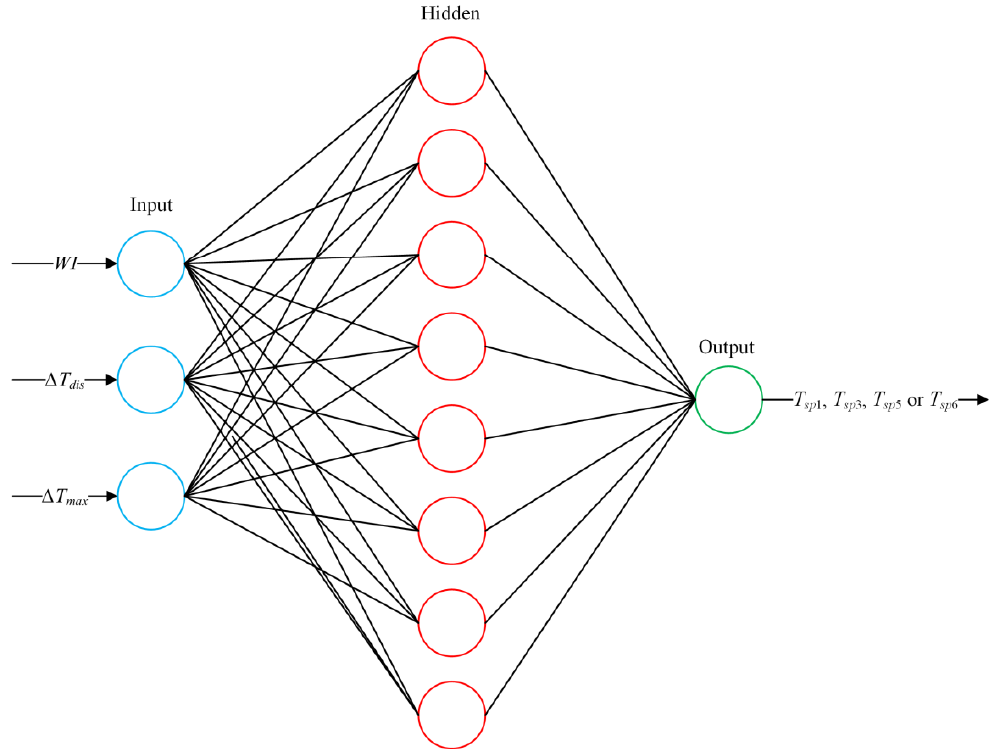
Figure 5. Back propagation ( BP) neural network prediction models